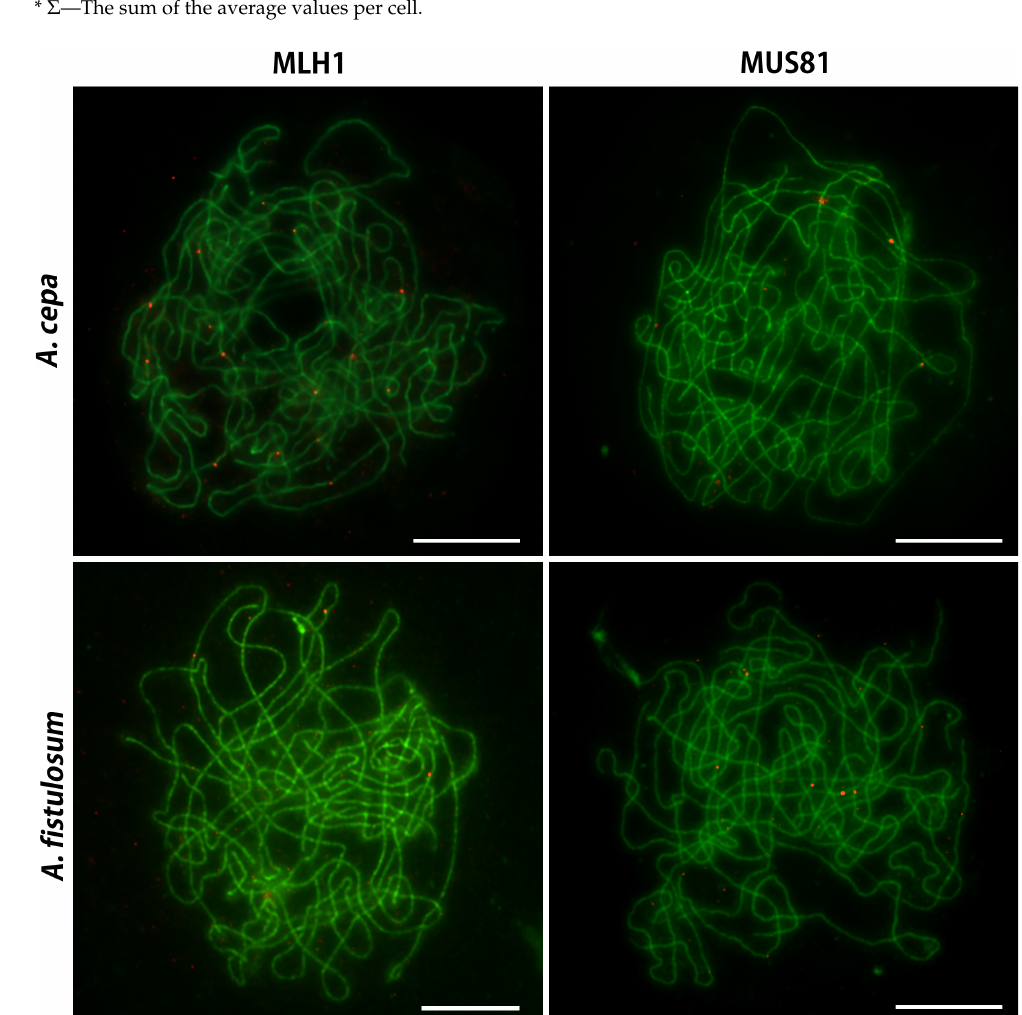
Figure 4. Immunolocalization of the MLH1/ZYP1 or MUS81/ZYP1 at pachytenes of A. cepa and A. fistulosum . MLH1 (on the left ) marks class I COs, and MUS81 (on the right ) marks class II COs. Bar = 10 µ